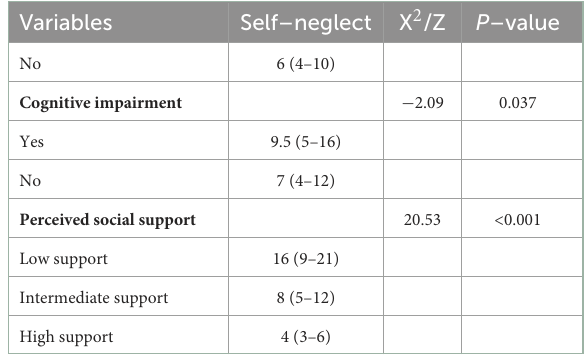
TABLE 2 Self-neglect comparisons among different characteristics.